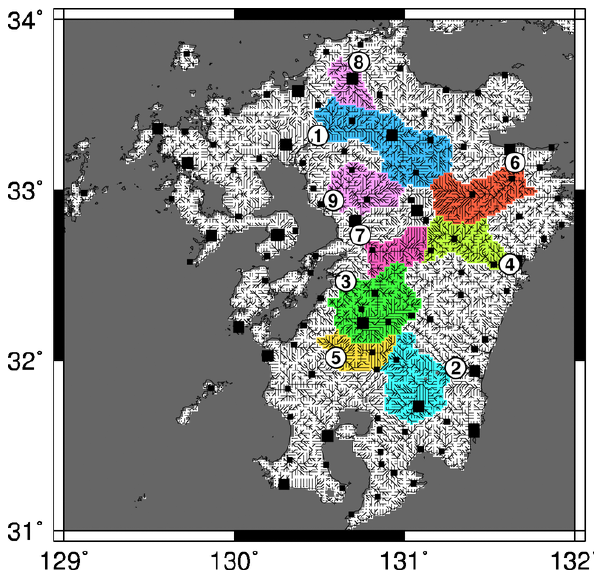
Figure 1. Study domain. Large and small squares represent manned and automated weather stations, respectively. Numbers in circles indicate gauging stations along major rivers. See Table 1 for a list of rivers and gauging stations. Colored areas are the catchment areas of the gauging stations. Numbers in triangles indicate dams located on the major rivers. See Table 2 for a list of the dams.